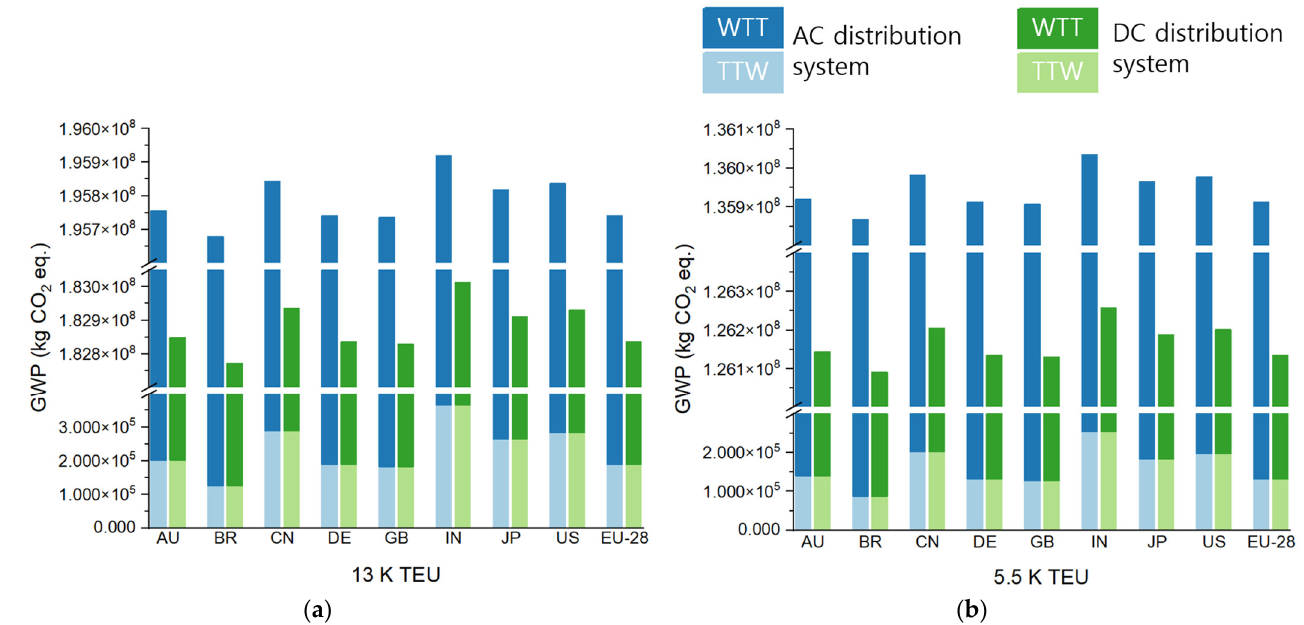
Figure 22. Preliminary LCA results; ( a ) 13K TEU, ( b ) 5,500 TEU.